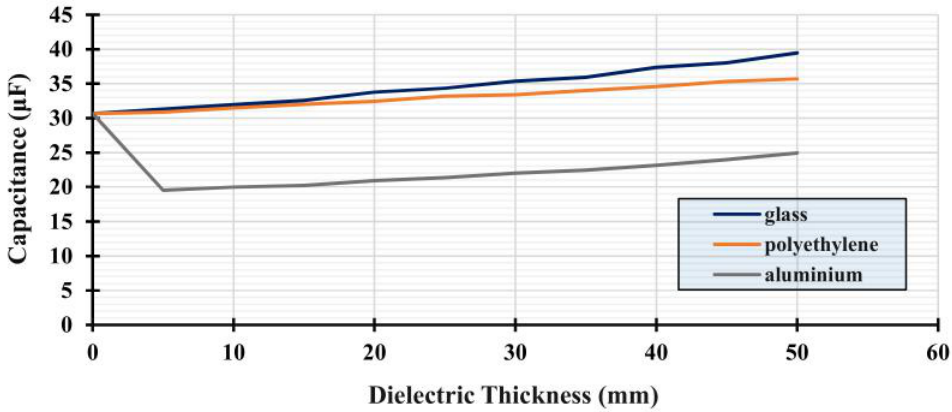
Figure 17. Mutual